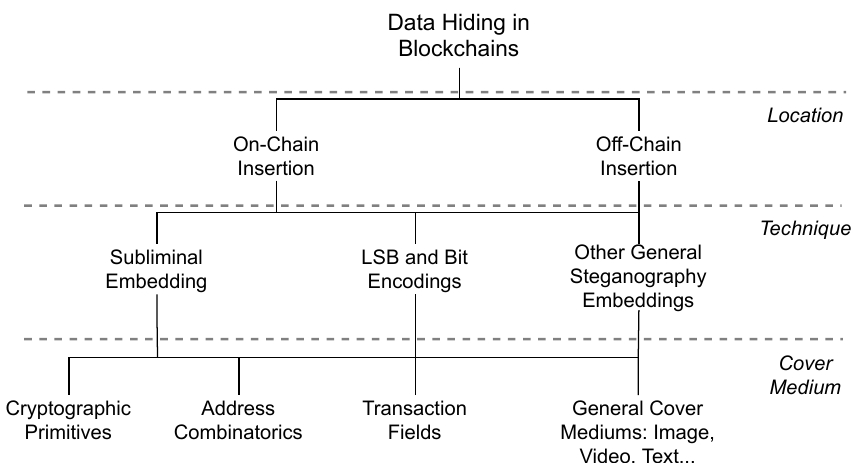
Figure 1. A classification of the blockchain steganography approaches in the literature.